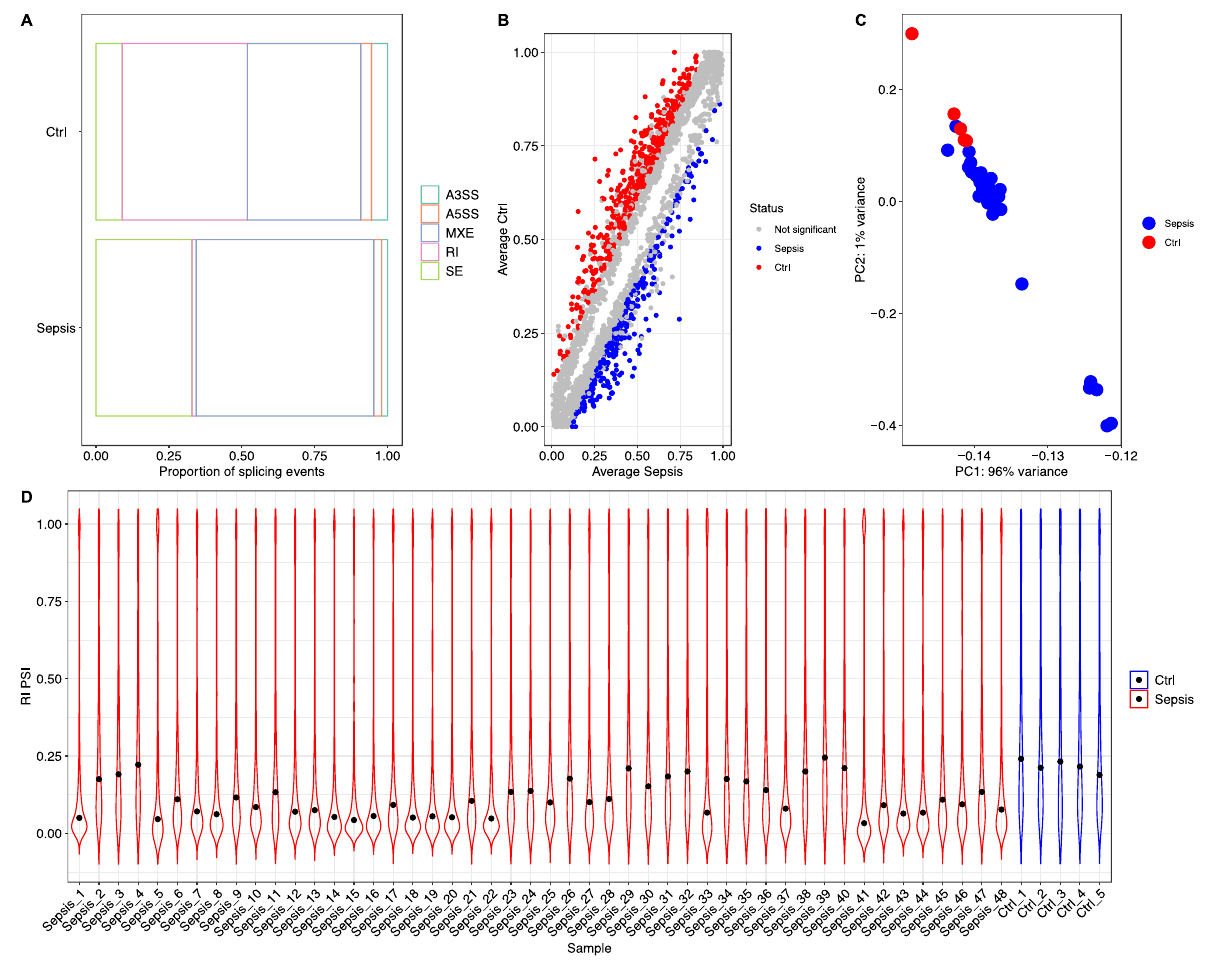
Figure 7. Alternative splicing analyzed by rMATS. ( A ) Distribution of the proportion of alternative splicing events. MXE account for a larger proportion of AS events in the patients with sepsis than in the controls. ( B ) Dot plot showing significantly different events involving MXE. The vertical and horizontal axes are the average PSI for the control and sepsis groups, and each dot represents one gene. ( C ) PCA plot showing the first two principal components of the PSI for an event involving MXE. The sepsis and control groups were easily separated by MXE. ( D ) The distribution of RI with the PSI for each sample. The control group showed higher values than the sepsis group. MXE mutually exclusive exons, RI retained intron, AS alternative splicing, PSI percent spliced in, PCA principal component analysis. Type of